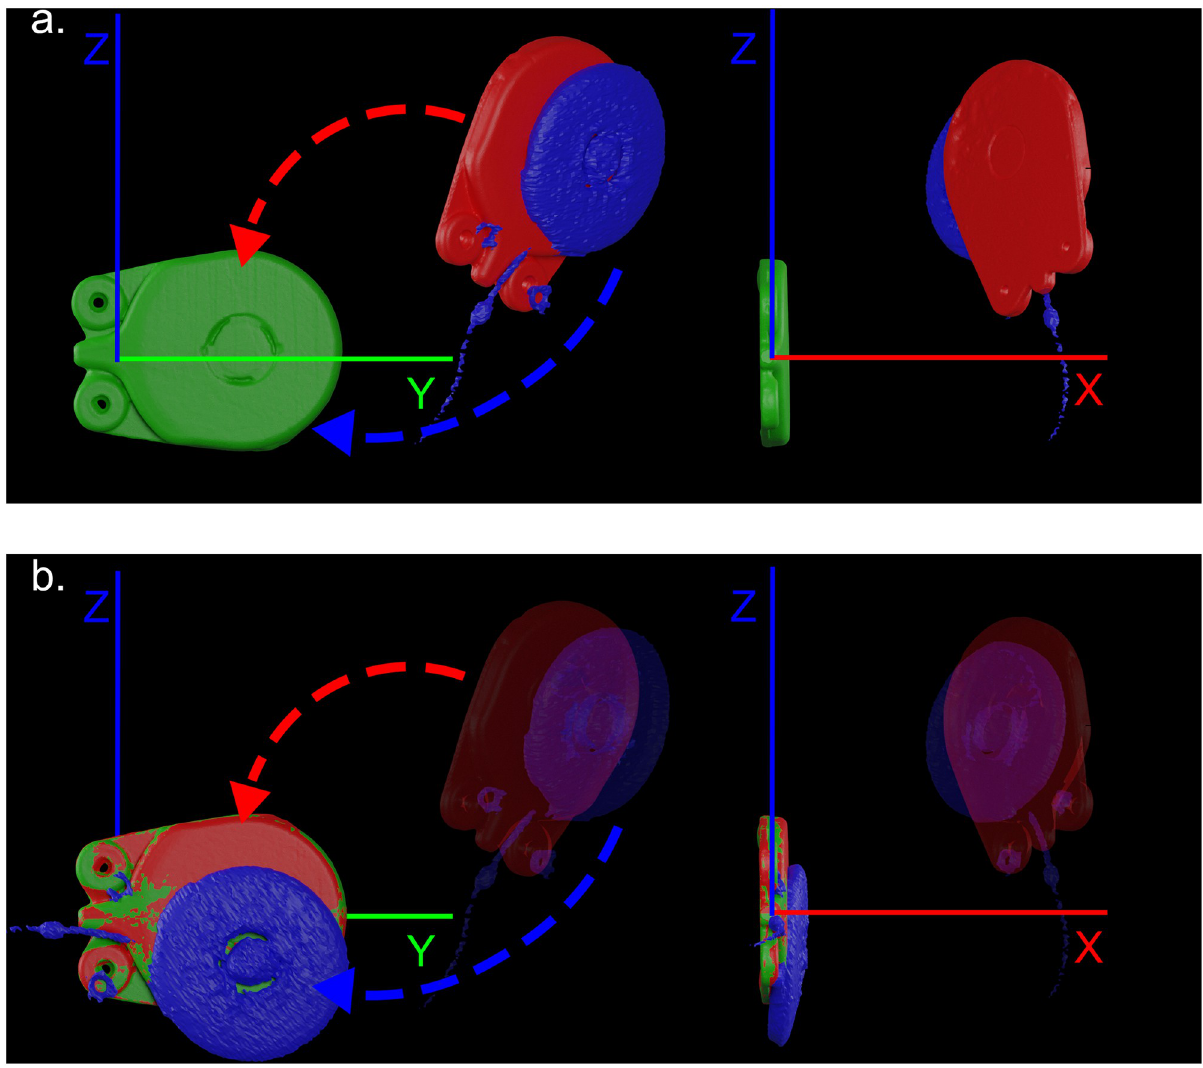
Fig 2. Analysis steps of the alignment of cochlear implants to eliminate errors due to skull size and planning variability. The X, Y, and Z axis are marked red, green, and blue, respectively. (a) Depiction of the manually placed cochlear implant (CI) at the origin of the coordinate system (0,0,0) (green color); the 3D model of the planned CI (red color); the 3D model of the implanted CI (blue color). (b) Registration of the planned CI (red color) towards the centered CI model (green color) using rigid surface